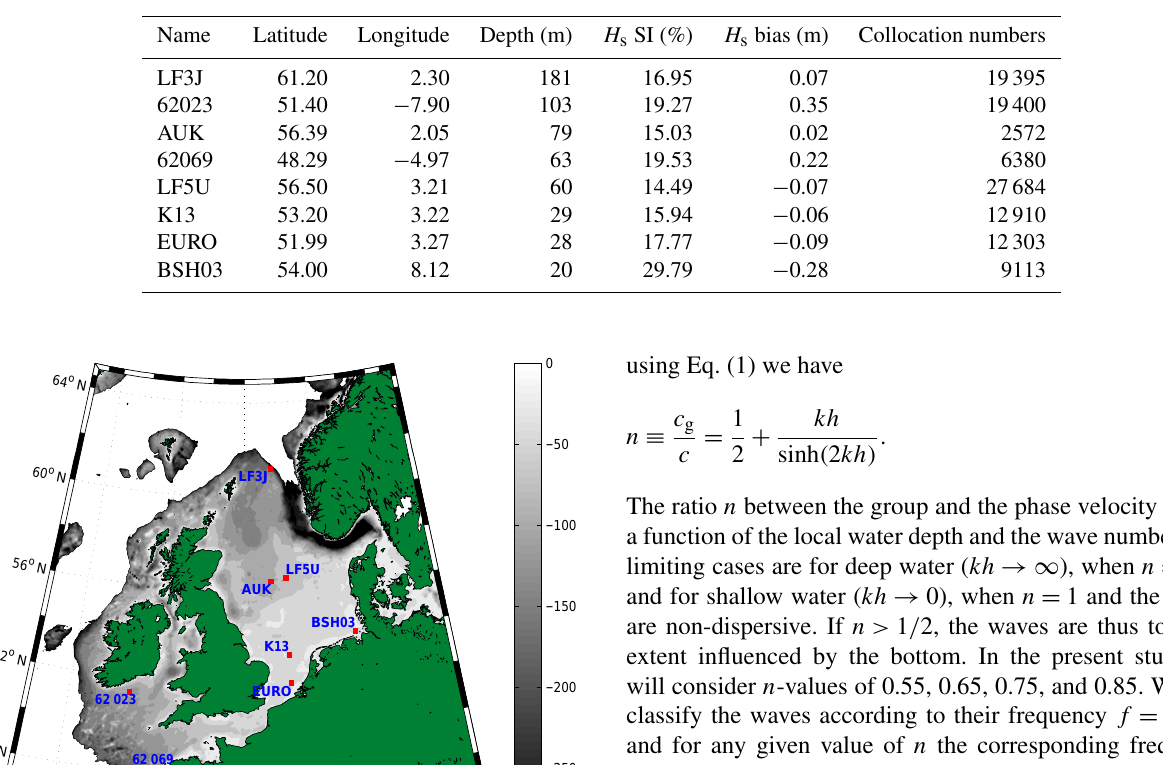
Table 1. Station names, positions, and depths, in addition to verification statistics for significant wave height ( H s ): scatter index (SI, standard deviation of error divided by the observation average) and bias. The rightmost column shows the number of collocated measurements used in deriving the statistics. The depths referred to here and in subsequent plots are the model depths.